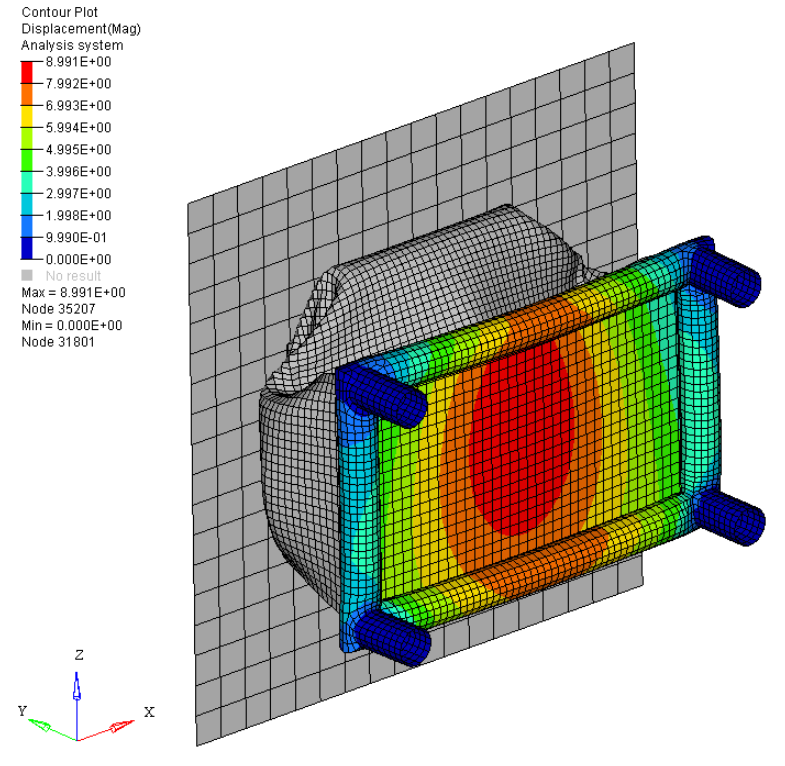
Figure 11. Displacement of the front part of the chassis (the base of the attenuator) at t = 43 ms (when the maximum deformation appears). The maximum displacement is 8.9